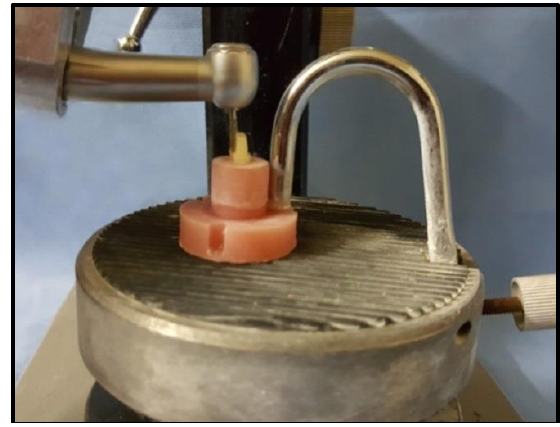
Figure 1: Tooth preparation using a modified dental surveyor.